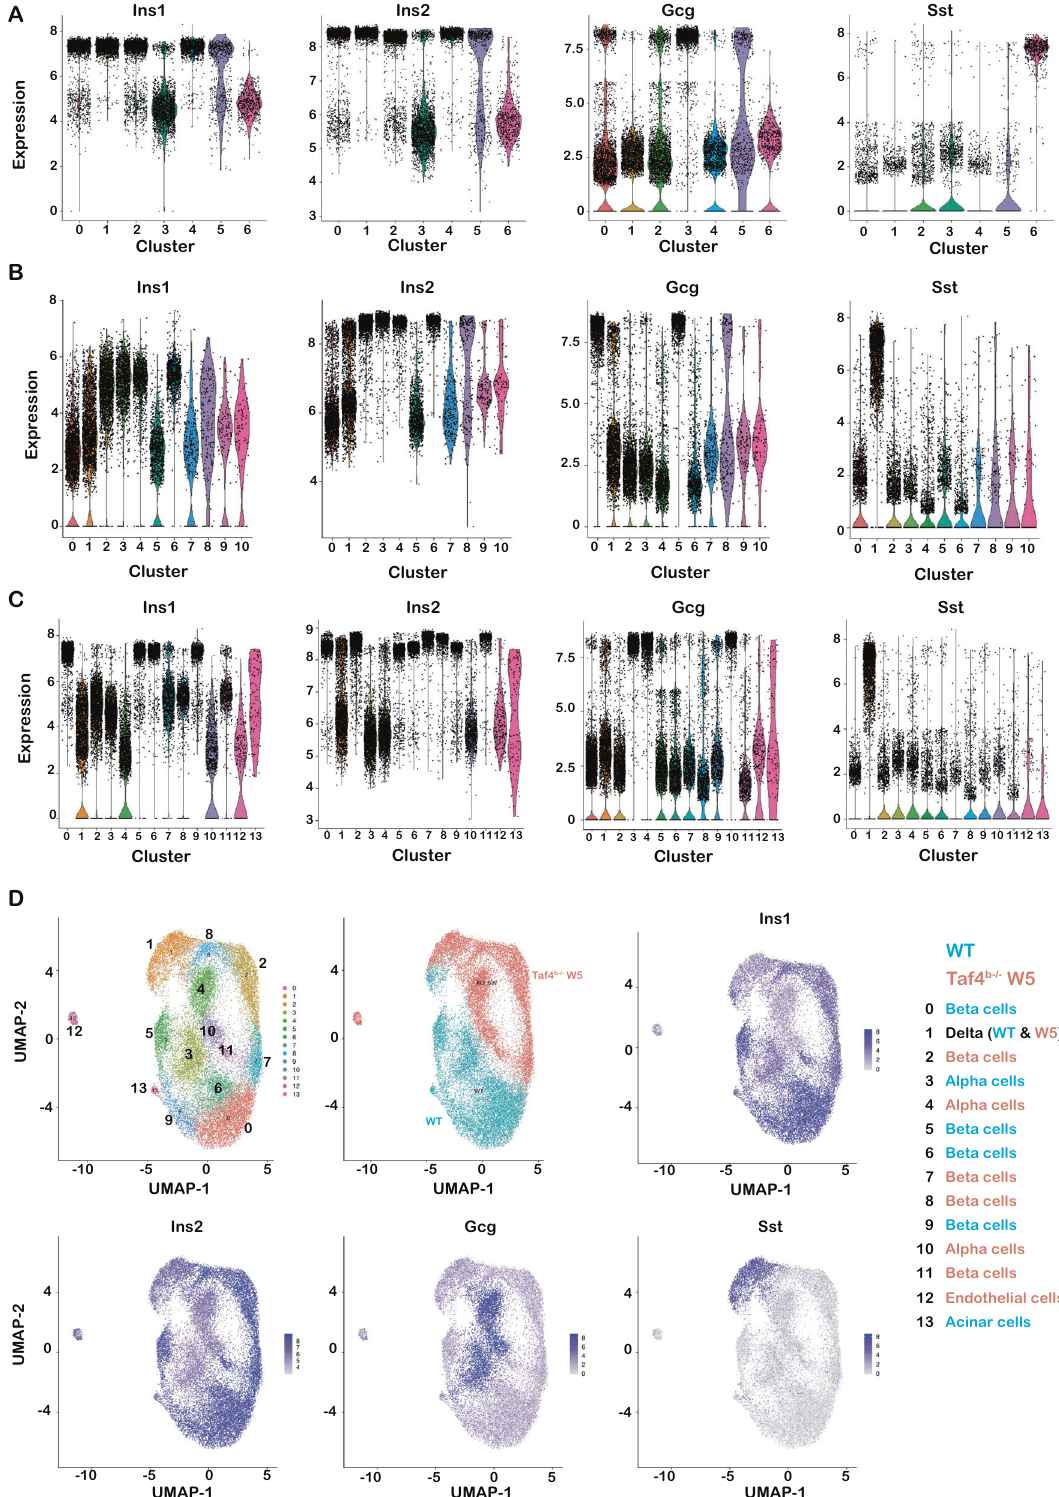
Fig. 4 Sc-RNA-seq of WT and week 5 mutant islets. A – C Violin plots of expression of the indicated genes in each cluster from WT islets ( A ), 5-week mutant islets ( B ) and the aggregate ( C ). D UMAP representations of the aggregate data, illustrating origin of cells from WT and mutant animals and the expression of the genes indicated in each